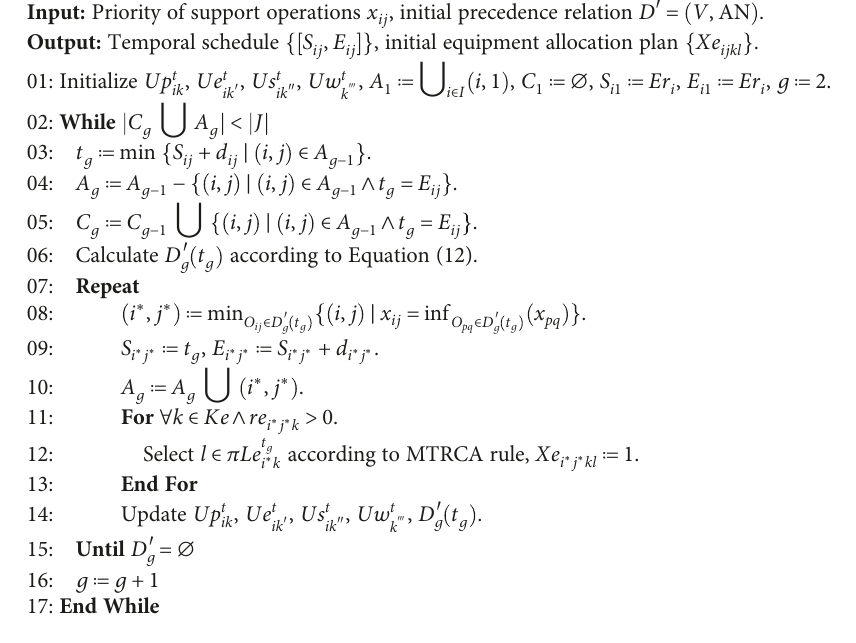
Algorithm 2: Algorithm of parallel schedule generation scheme for aircraft deck